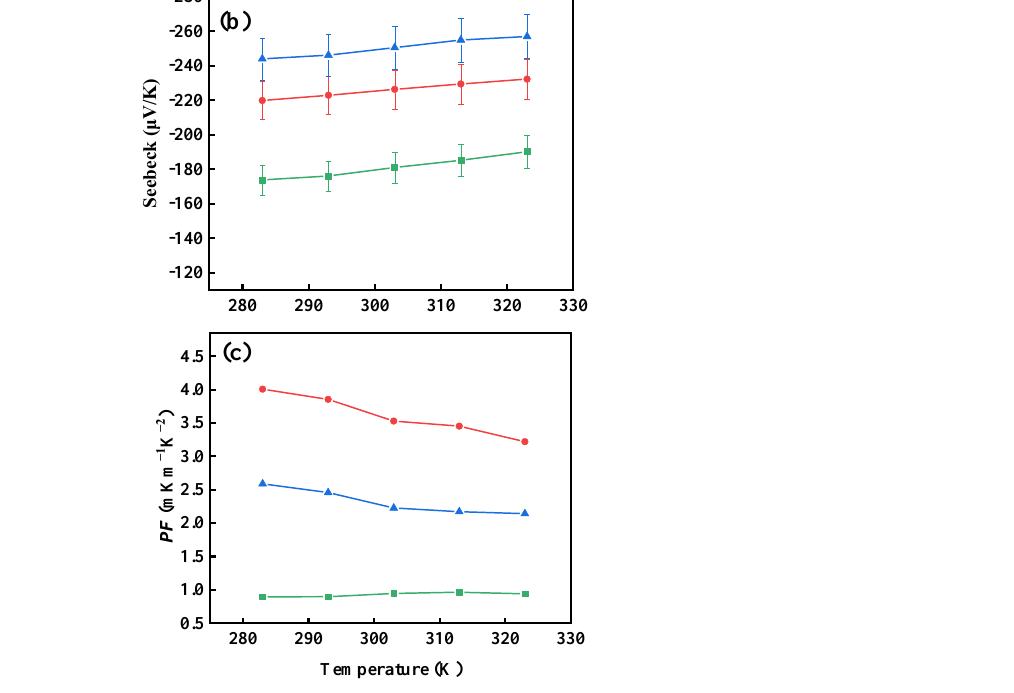
Figure 4. ( a ) The σ , ( b ) S , and ( c ) calculated PF of the as-drawn fibers and the annealed fibers at 10 – 50 °C. Table 1. σ , S , κ es, and calculated ZT of the n-type Bi 2 Te 3 -based fibers and Bridgman-method-growth crystals near room